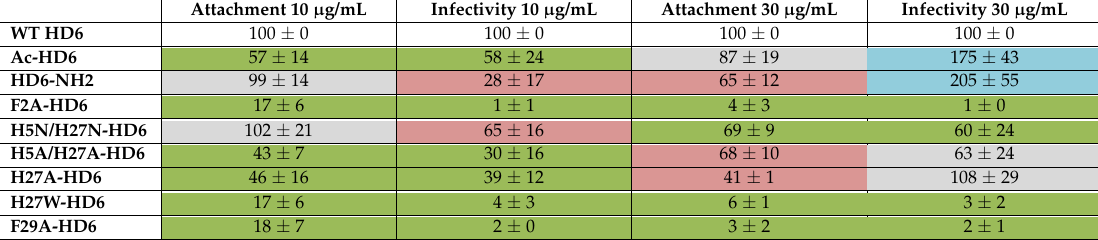
activity for HIV attachment and infectivity at a specific concentration compared to WT HD6; but not consistent profiles of attachment and infectivity, compared to WT HD6 ( p < 0.05);